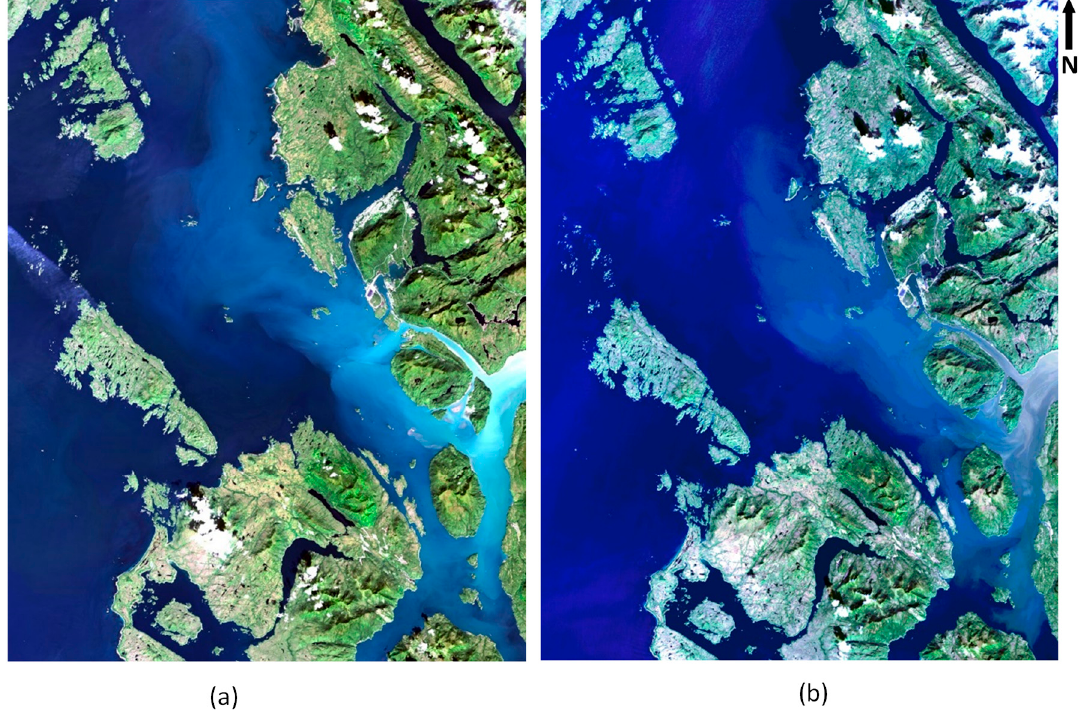
Figure 2. Enhanced Landsat 8 satellite image for ( a ) 28 August 2013 (ebb flow, under 665 m 3 /s river discharge from the Skeena River) and ( b ) 5 April 2015 (flood flow, under 200 m 3 /s river discharge from the Skeena River).